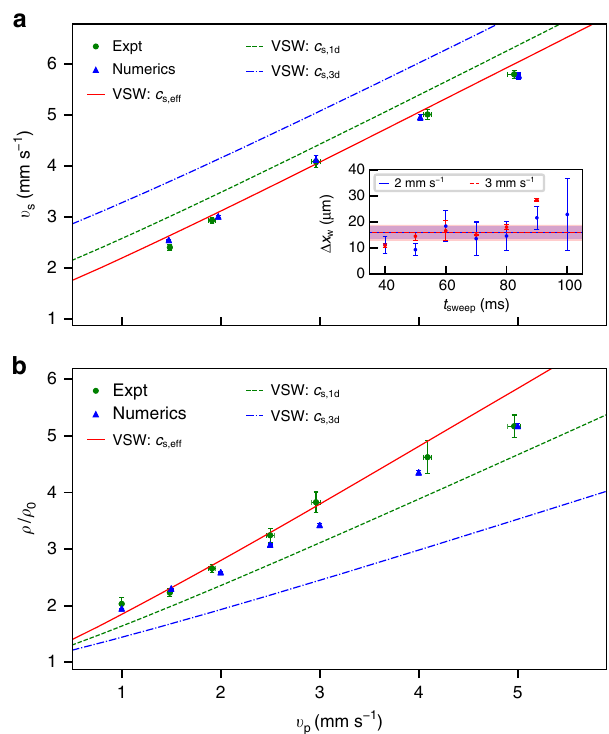
Fig. 2 Shock speed, peak density, and shock width vs. piston speed. Analyzed experimental (green dots) and numerical (blue triangles) results for increasing piston velocity are plotted with overlaid theory curves for VSW (red solid line), using an effective c s,eff = 1.35 mm s − 1 obtained from a fi t of the experimental and numerical data to the VSW theory prediction. VSW theory curves are also calculated for c s,1d = 1.75 mm s − 1 (green dashed) and c s,bulk = 2.47 mm s − 1 (blue dot-dashed). a Shock front speed. Inset, Shock front width at different times for piston speeds 2 mm s − 1 (blue solid) and 3 mm s − 1 (red dashed), with corresponding error (shaded regions). b The normalized plateau density is determined by measuring the plateau integrated density when the piston reaches the center of the BEC. Weighted mean ± s.d. are plotted for three ( a ) and fi ve ( b ) sets of data.